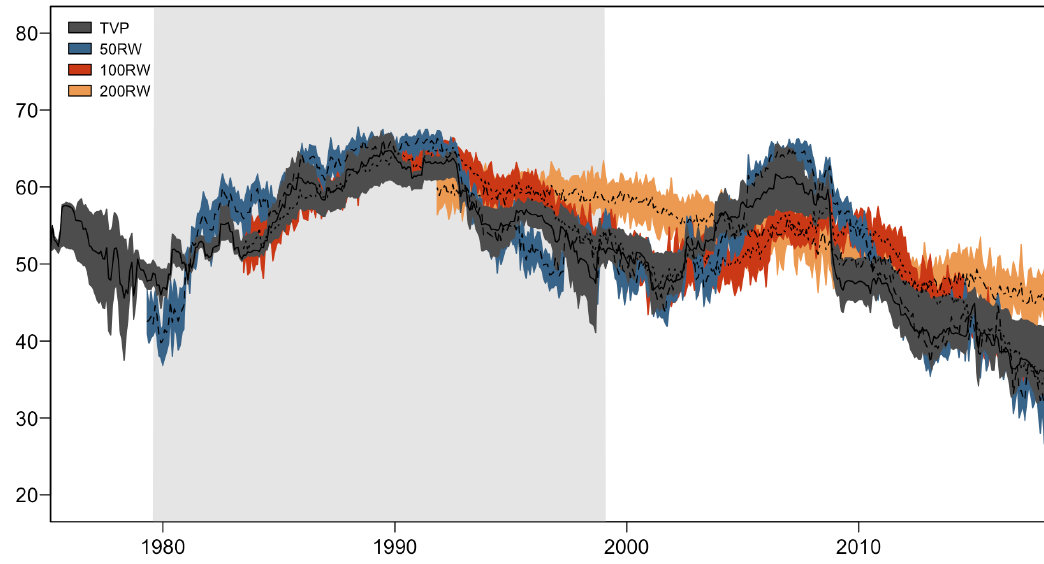
Figure 13. Confidence intervals: Dynamic total